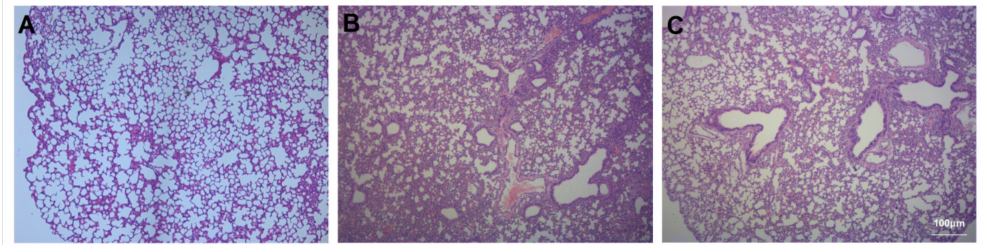
Figure 2. Histological assessment of the lung tissue: ( A ) Con group; ( B ) Bl group; ( C ) Bl + MSC group ( A – C , 100 ×